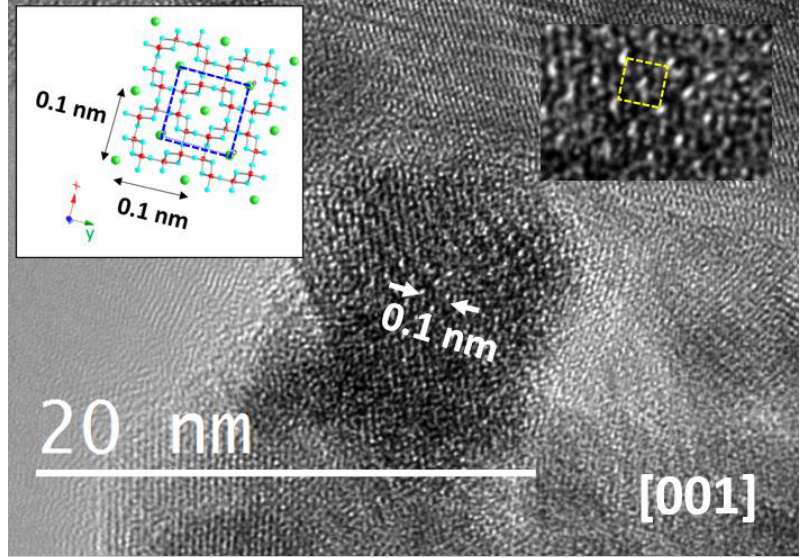
Figure 8. HRTEM image along the [001] direction corresponding to a 15% Fe-doped sample. An enhanced detail is shown in the right-upper part, and the schematic model along this projection is included in the left-upper part.